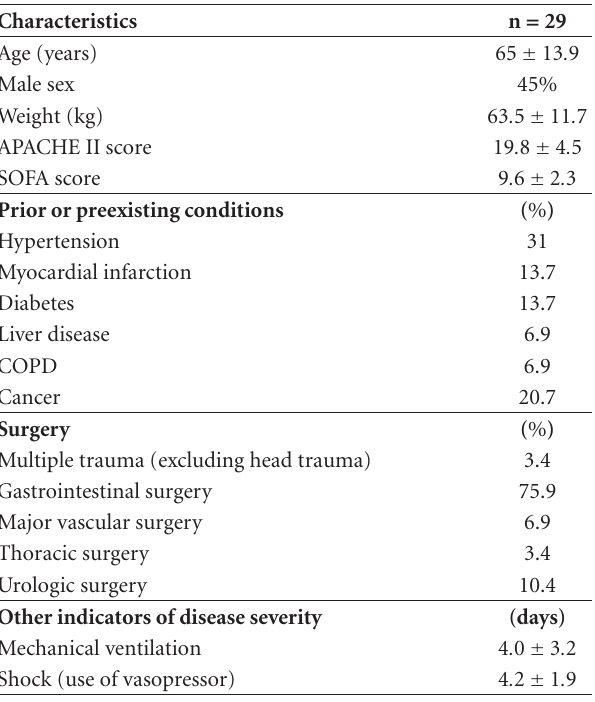
Table 1: Baseline characteristics of the patients.